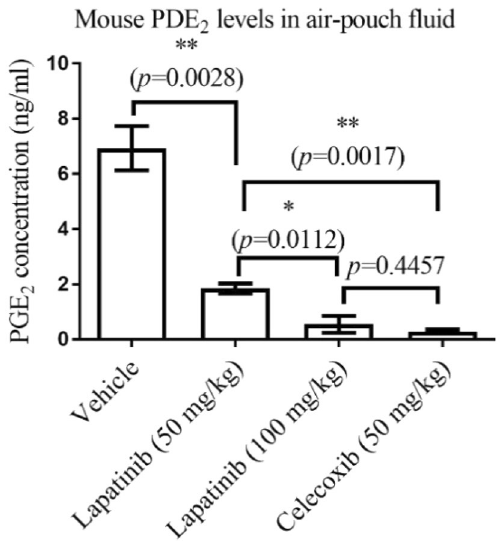
Figure 2. Data from in vivo assays using the mouse air-pouch model (n = 5 for each group) with lapatinib or celecoxib given PO. The air-pouch fluid collected from mice were analyzed by ELISA assay for the PGE 2 concentrations. GraphPad Prism 7 software (GraphPad Software, La Jolla, CA) was used to perform the one- way analysis of variance (ANOVA) with post hoc tests.